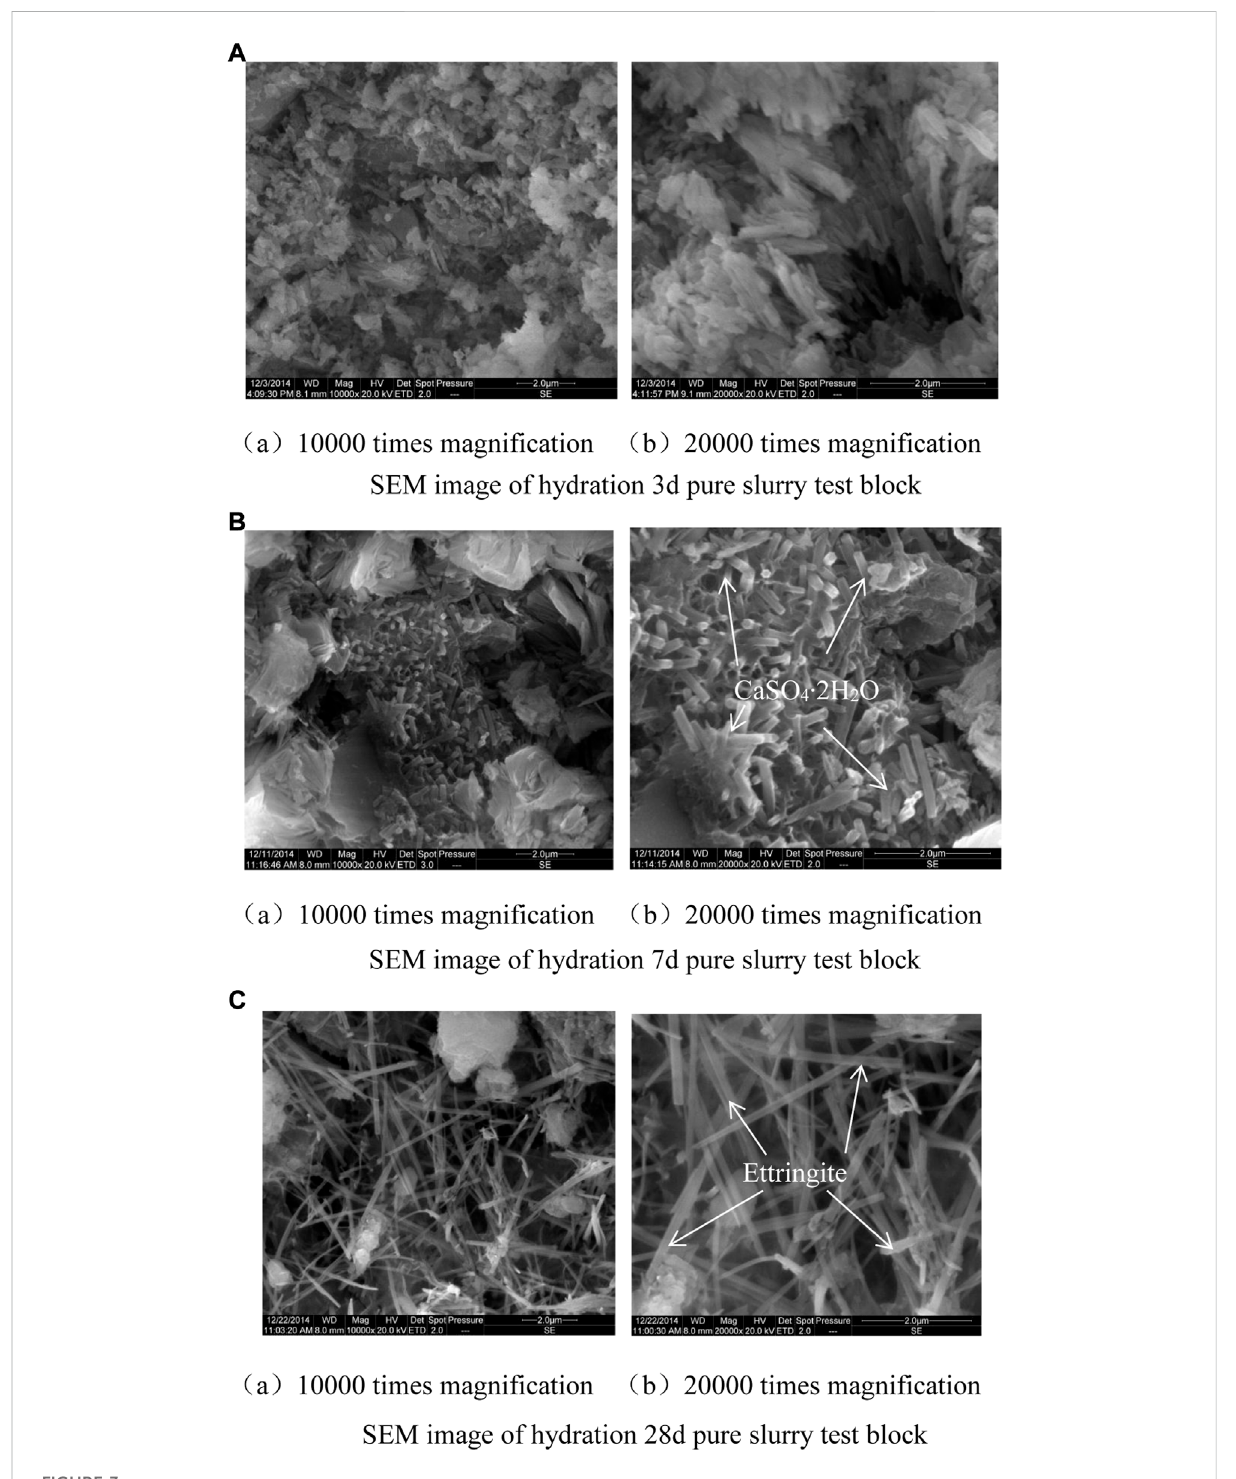
FIGURE 3 SEM image of new cementitious material. (A) SEM image of hydration 3d pure slurry test block. (B) SEM image of hydration 7d pure slurry test block. (C) SEM image of hydration 28d pure slurry test